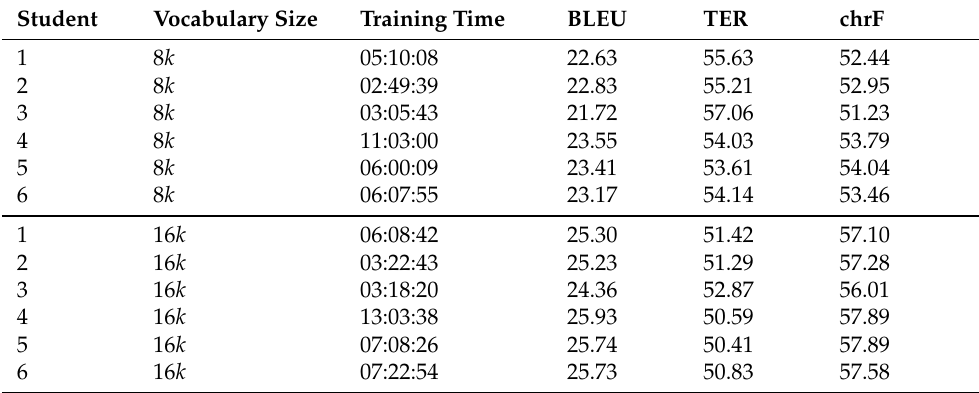
Table 6. Comparison of the performance of the student models with varying vocabulary sizes.